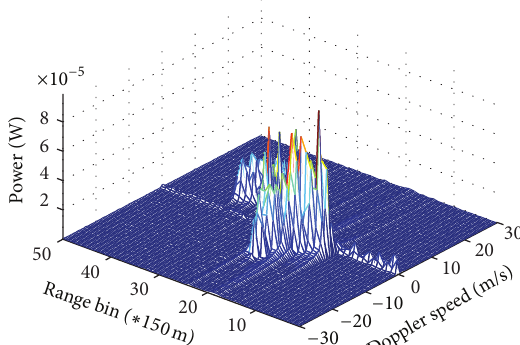
Figure6:RainEchoSpectrumDistributionofthethirtiethscanline (three-dimensional diagram).